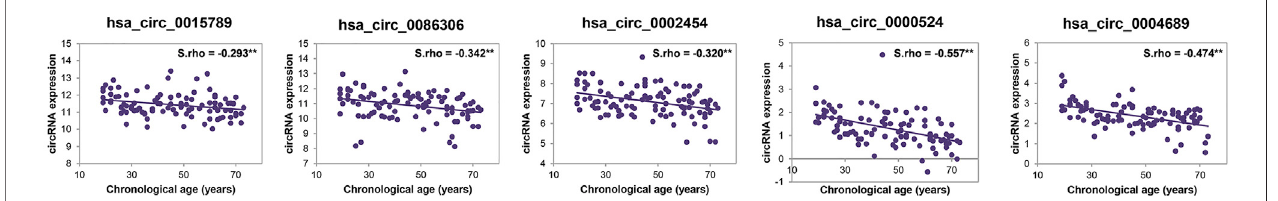
FIGURE 3 | Scatter plots of the Δ Ct-value versus age for 5 age-related circRNAs in 100 samples for modeling.